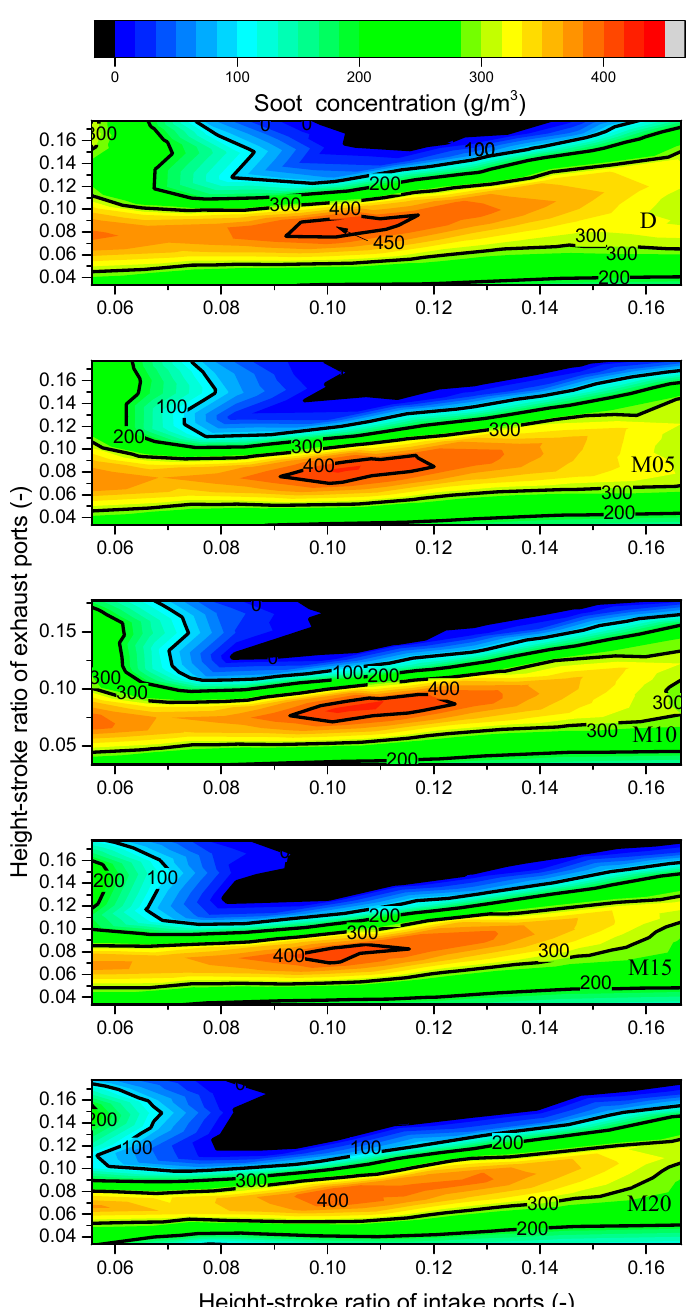
Figure 14. Soot concentration under the interaction of the intake and exhaust